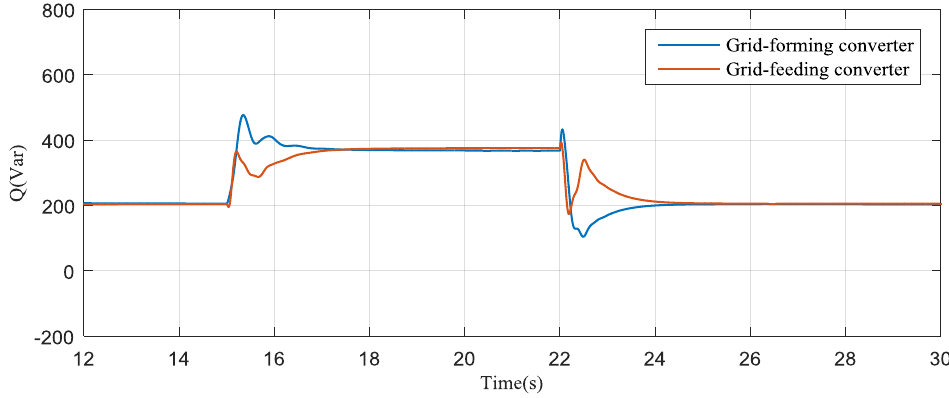
Figure 23. Reactive power of the droop control considering virtual impedance.